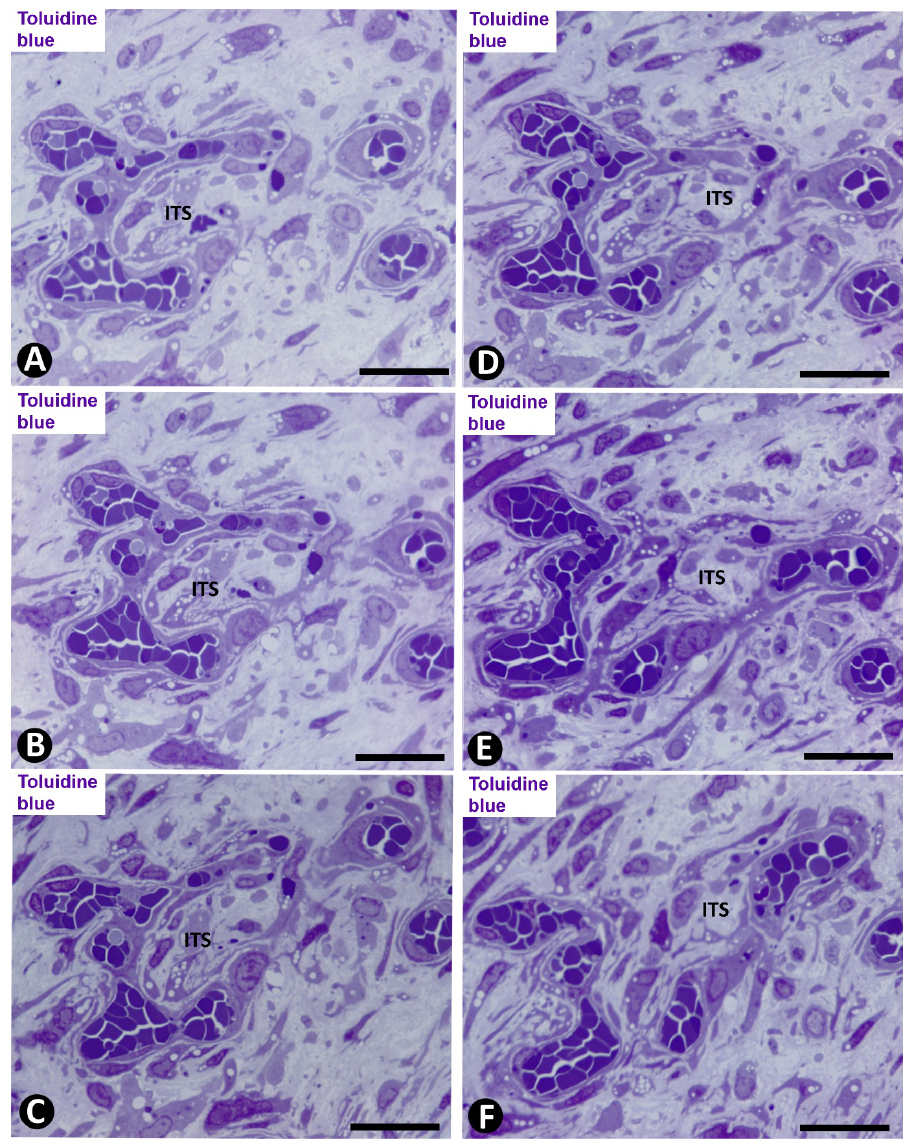
Figure 10. Intussusception with regression of a newly formed vessel loop in an occluded arterial segment. ( A – F ): Serial semithin sections, in which the appearance/disappearance of interendothelial contacts, contact perforations and fragmentation in regressive capillary-like structures are showed in the vessel loop. ITS: Interstitial tissue structure. Toluidine blue. Bar: ( A – F ): 30 μ m.